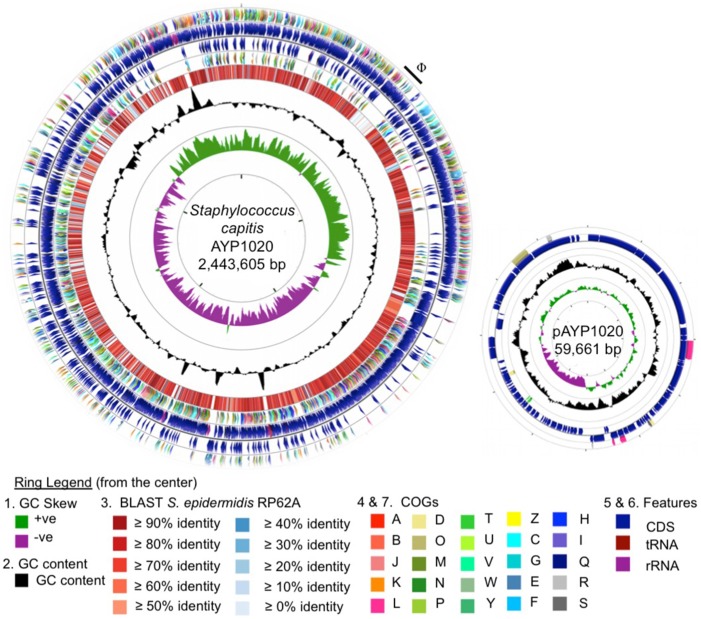
Circular representation of the S. capitis AYP1020 chromosome and its plasmid, pAYP1020. For the chromosome, the first (innermost) ring indicates the GC skew, followed by the GC content (second ring). The third ring indicates the degree of amino acid identity across all CDS of S. capitis AYP1020 compared to S. epidermidis RP62a, as determined by BLASTp and scaled according to percent identity as indicated in the key (Altschul et al., 1997). Colored arrows on the fourth and seventh rings represent the following COG categories (Tatusov et al., 2000); A, B, J, K, L, information and storage and processing; D, O, M, N, P, T, U, V, W, Y, Z, cellular processes and signaling; C, G, E, F, H, I, Q, metabolism; R and S, poorly characterized, on the reverse and forward strands, respectively. The fifth and sixth rings represent the CDS (blue), tRNA (maroon), and rRNA (purple) on the reverse and forward strands, respectively. For the genome, the scale displayed in the center of the graphic represents 500 kb. For the plasmid, the scale represents 5 kb. The images were generated using CGview (Grant et al., 2012).